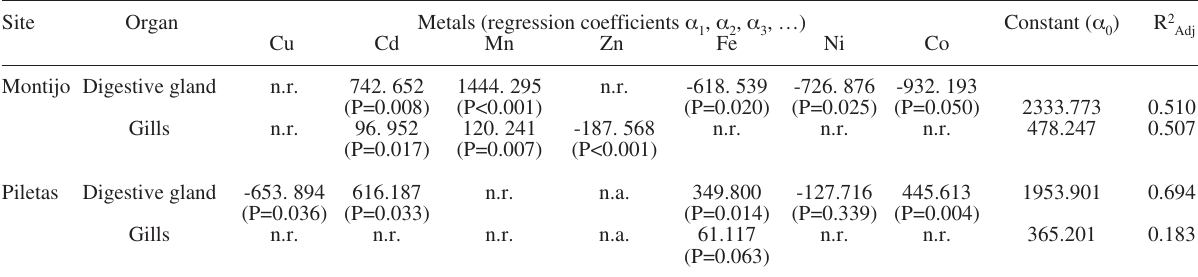
table. Number of samples: Montijo=17, Piletas=14. There are no data for Zn for the Piletas